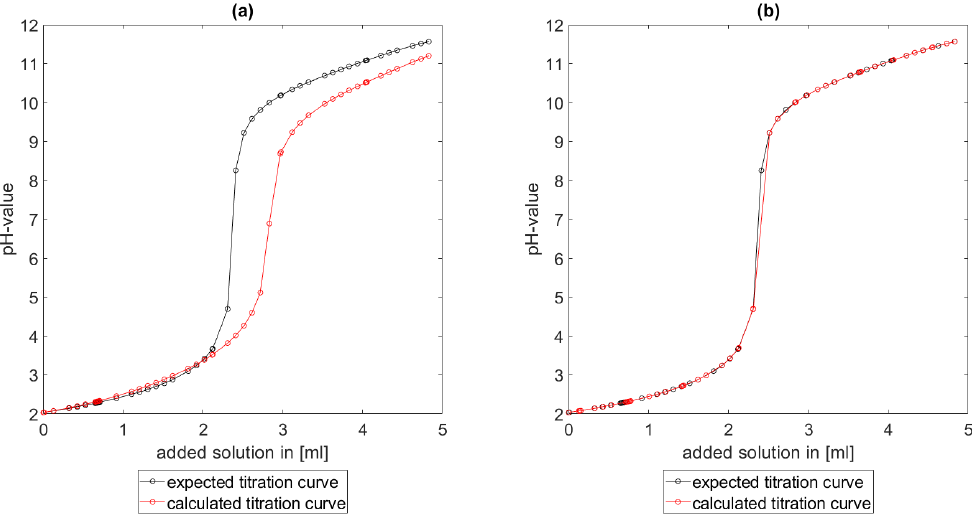
Figure 4. ( a ) Comparison of the initial titration curve regarding parameters in Table 2, ( b ) Comparison of the optimized titration curve with the initial titration curve; the resulting stability constants can be found in Table 2.